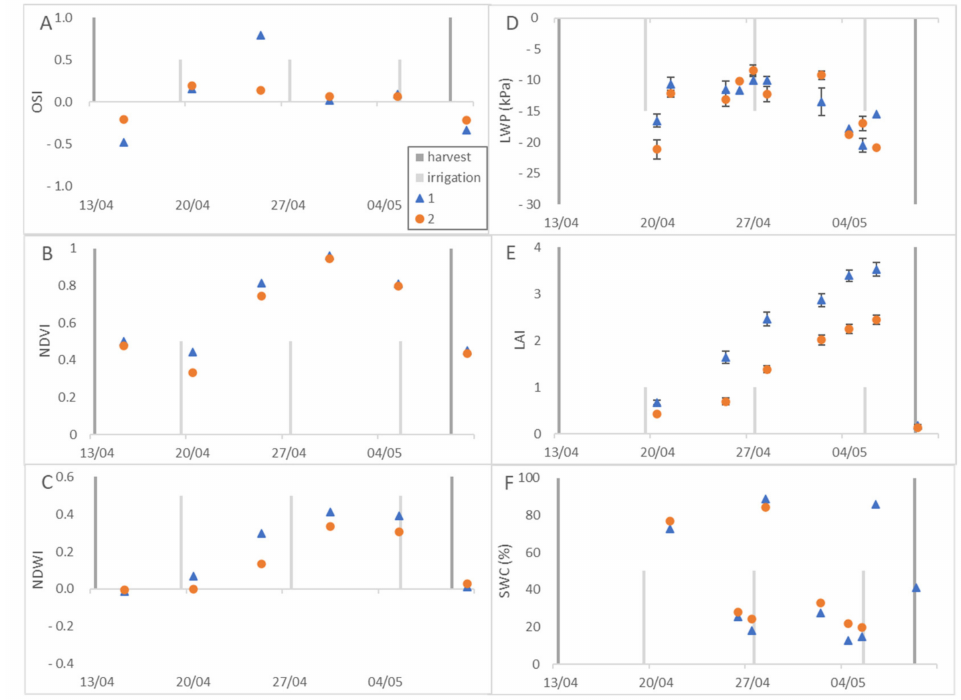
Figure 5. Spectral data ( A – C ) and crop measurements ( D – F ) sites 1 and 2, second growth